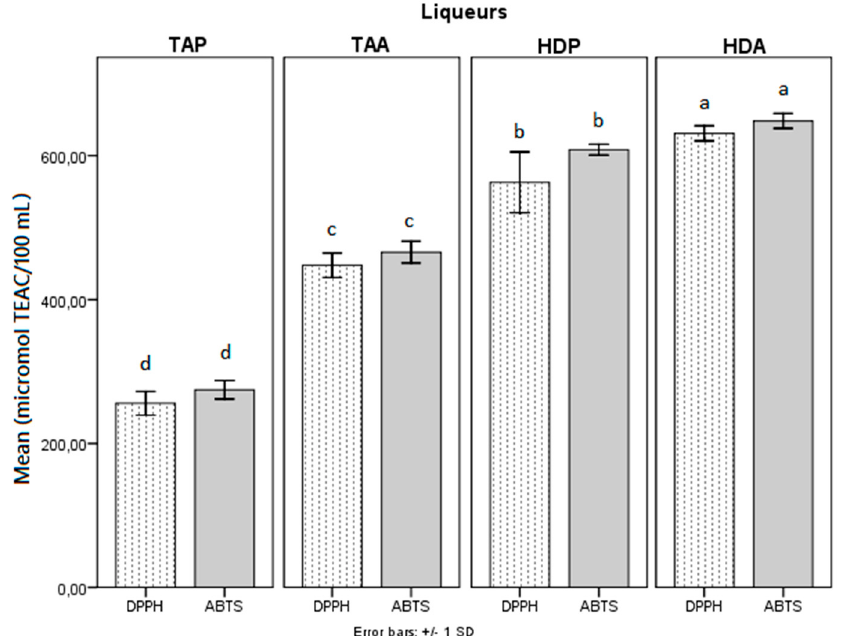
Figure 1. Antioxidant activity in vitro of mango peel liquors obtained by different methods. Legend: had = Haden mango peel liqueur by alcoholic maceration, HDP = Haden mango peel liqueur by maceration with pectinase, TAA = Tommy Atkins mango peel liqueur by alcoholic maceration, TAP = Tommy Atkins mango peel liqueur by maceration with pectinase. Averaged bars followed by equal letters do not differ from each other by the Tukey test at 5% error